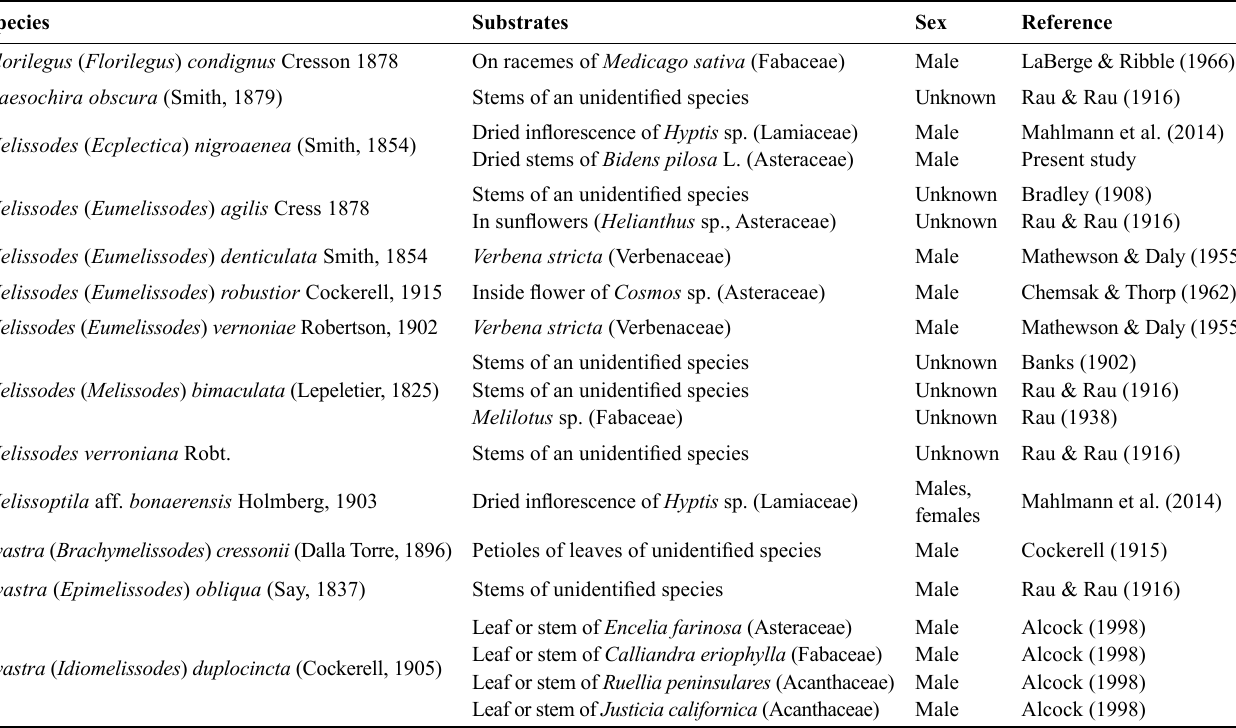
Table 1. Sleeping aggregations records of Eucerini available in the literature. Species Substrates Sex